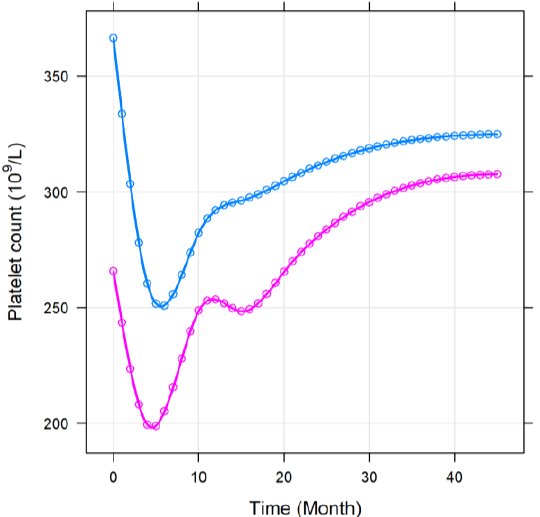
Figure 6. Longitudinal changes in platelet counts throughout the study within the PD-1 < 26 ng/mL (blue) and PD-1 > 26 ng/mL (magenta) groups. PD-1: plasma programmed cell death protein 1.